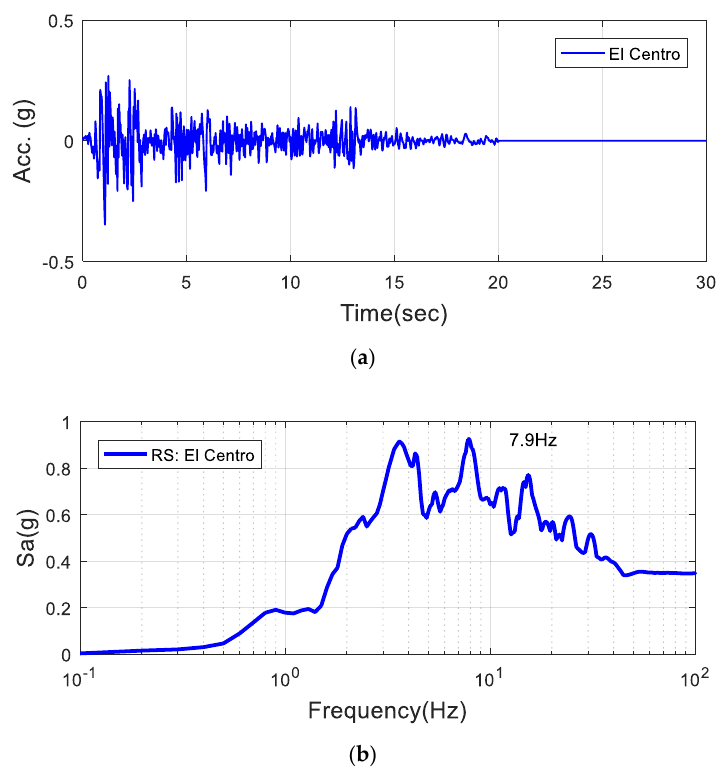
Figure 13. El Centro earthquake: ( a ) time history and ( b ) response spectrum.